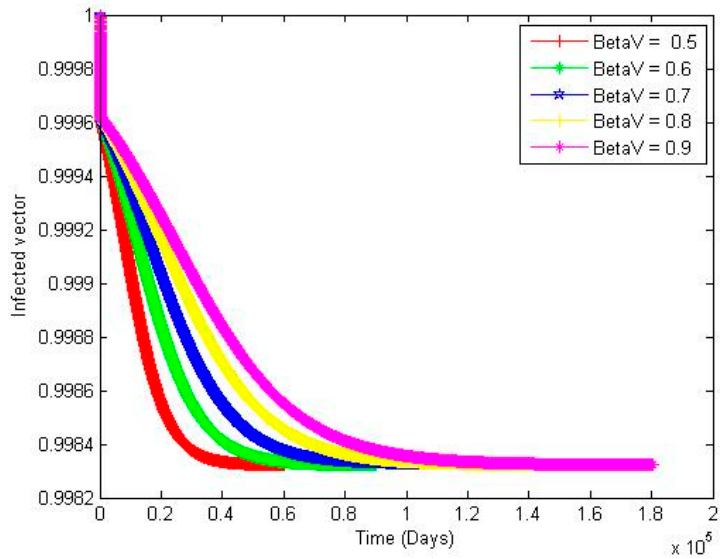
I toward the endemic steady state for 0